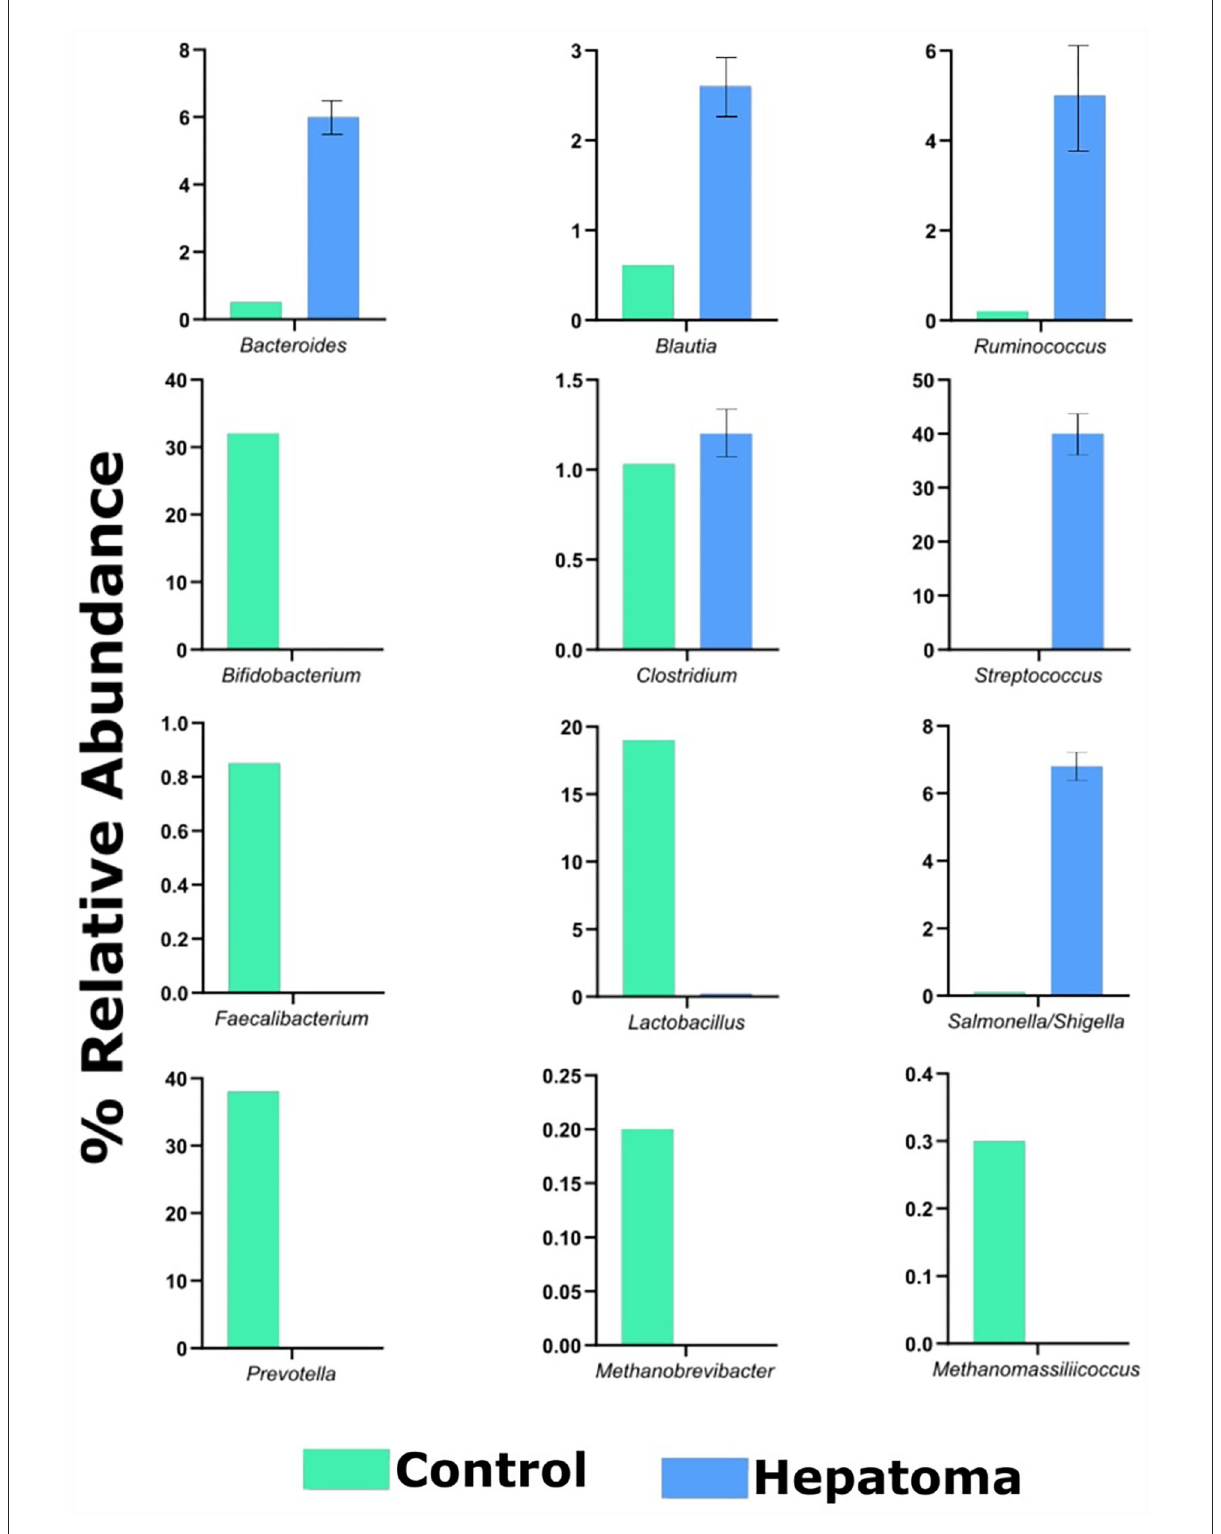
FIGURE6 Bar plot of relative abundance of cultured microorganisms with clinical relevance. Analysis of relative abundances of beneficial and pathogenic ASVs was carried out in CRC (green columns) and HRC (blue columns). All species showed significance of P < 0.001 vs. control